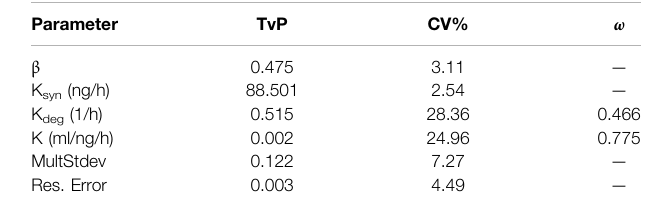
TABLE 4 | Population PD results of oral administration of HY-021068 to beagle